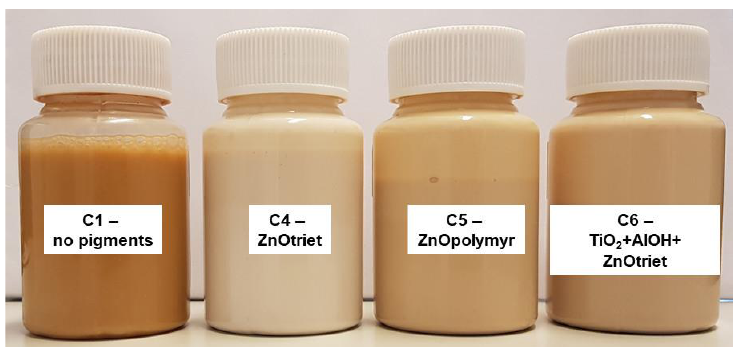
10 of 12 Figure 3. Correlation of RPF with µ s ‘ for scattering coefficients at 400 nm (R 2 = 0.98). 4. Conclusions The results provide sound scientific evidence that physical filters can act as genera- tors of free radicals. These free radicals are released in the formulation where they can oxidize other ingredients, mainly antioxidants and/or other compounds with low redox potential. Hence, physical filters must be considered as oxidizing agents that can reduce the antioxidative potential of formulations or even render them pro-oxidative. If the for- mulation becomes pro-oxidative the formulation will lose its beneficial effect on skin, too. The pro-oxidative effects and the degradation of ingredients can be circumvented by add- ing powerful antioxidants. The influence of physical filters on the anti-oxidative potential of formulations can be assessed ex vivo by EPR spectroscopy. A simple in vitro method is also available. A validation of this new method that allows for a complete in vitro — ex vivo correlation is now needed. Author Contributions: A.L., Y.L., J.Z., C.M.K., J.L. and M.C.M. conceived and designed the concept of the study and methodology, S.S., S.B.L. and S.W. performed the experimental investigations, data analysis and interpretation of the data was done by A.L., Y.L., J.Z., C.M.K., J.L., M.C.M. and S.B.L. M.C.M., C.M.K., and S.B.L. prepare the original draft. All authors have read and agreed to the pub- lished version of the manuscript. Funding: The investigation has been supported by Shanghai Pechoin Daily Chemical Corporation,